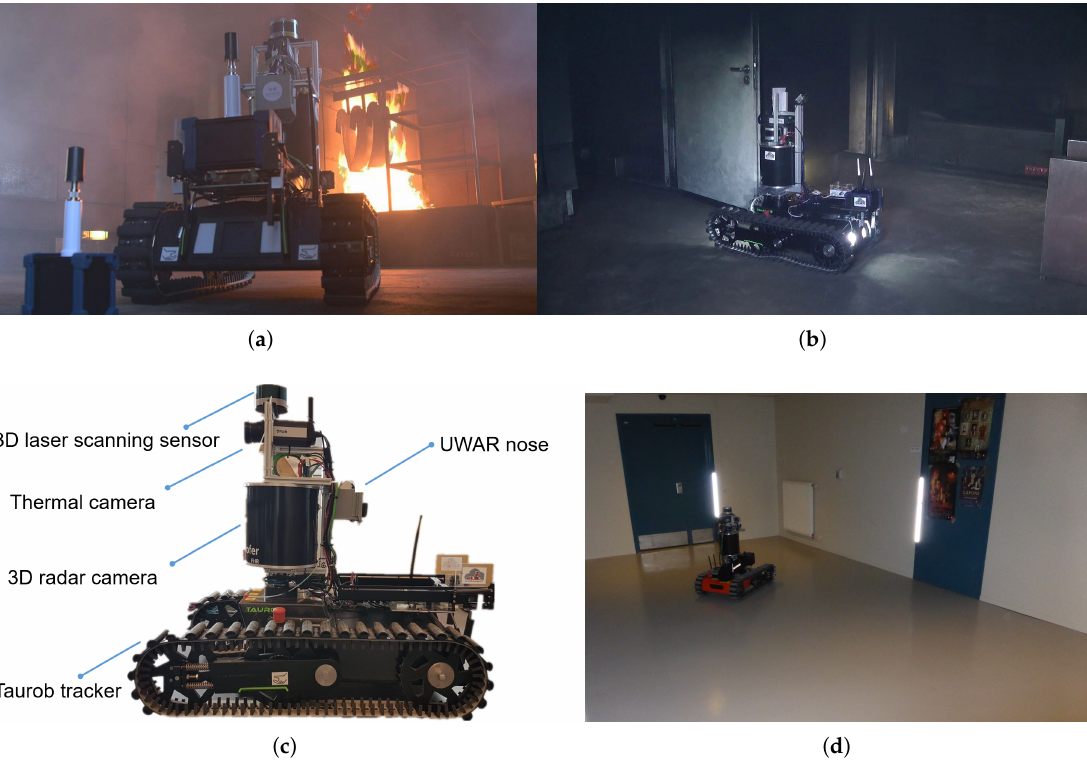
Figure 8. ( a , b ): Real-world working environments for the SmokeBot, which are imitated in a firefighter training facility; ( c ): SmokeBot sensor set-ups; ( d ): Experimental